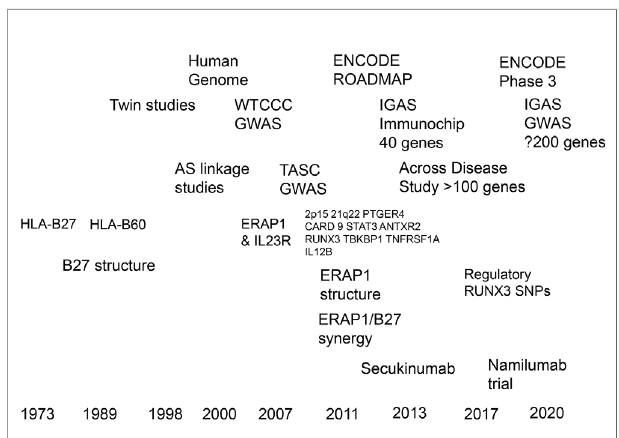
FIGURE 3 | Timelines of progress in translating the genetics of ankylosing spondylitis towards